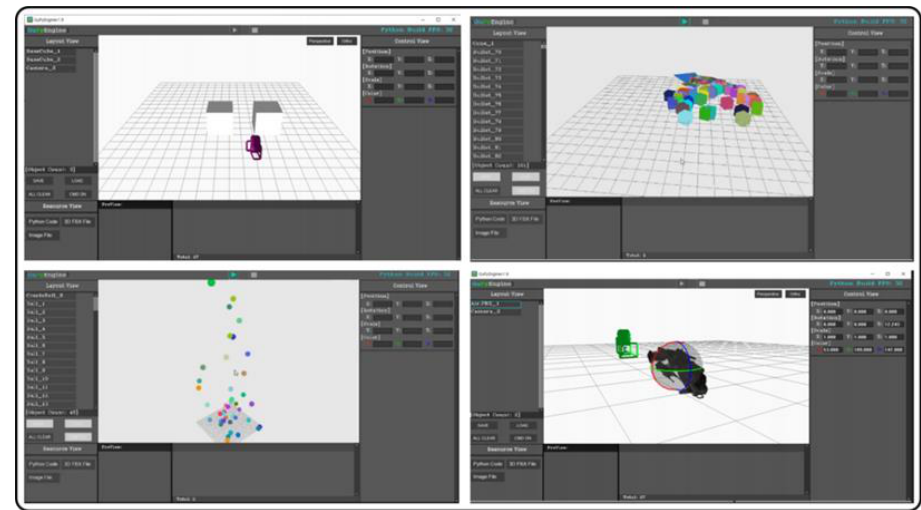
Figure 4. Screenshots of GuPyEngine.